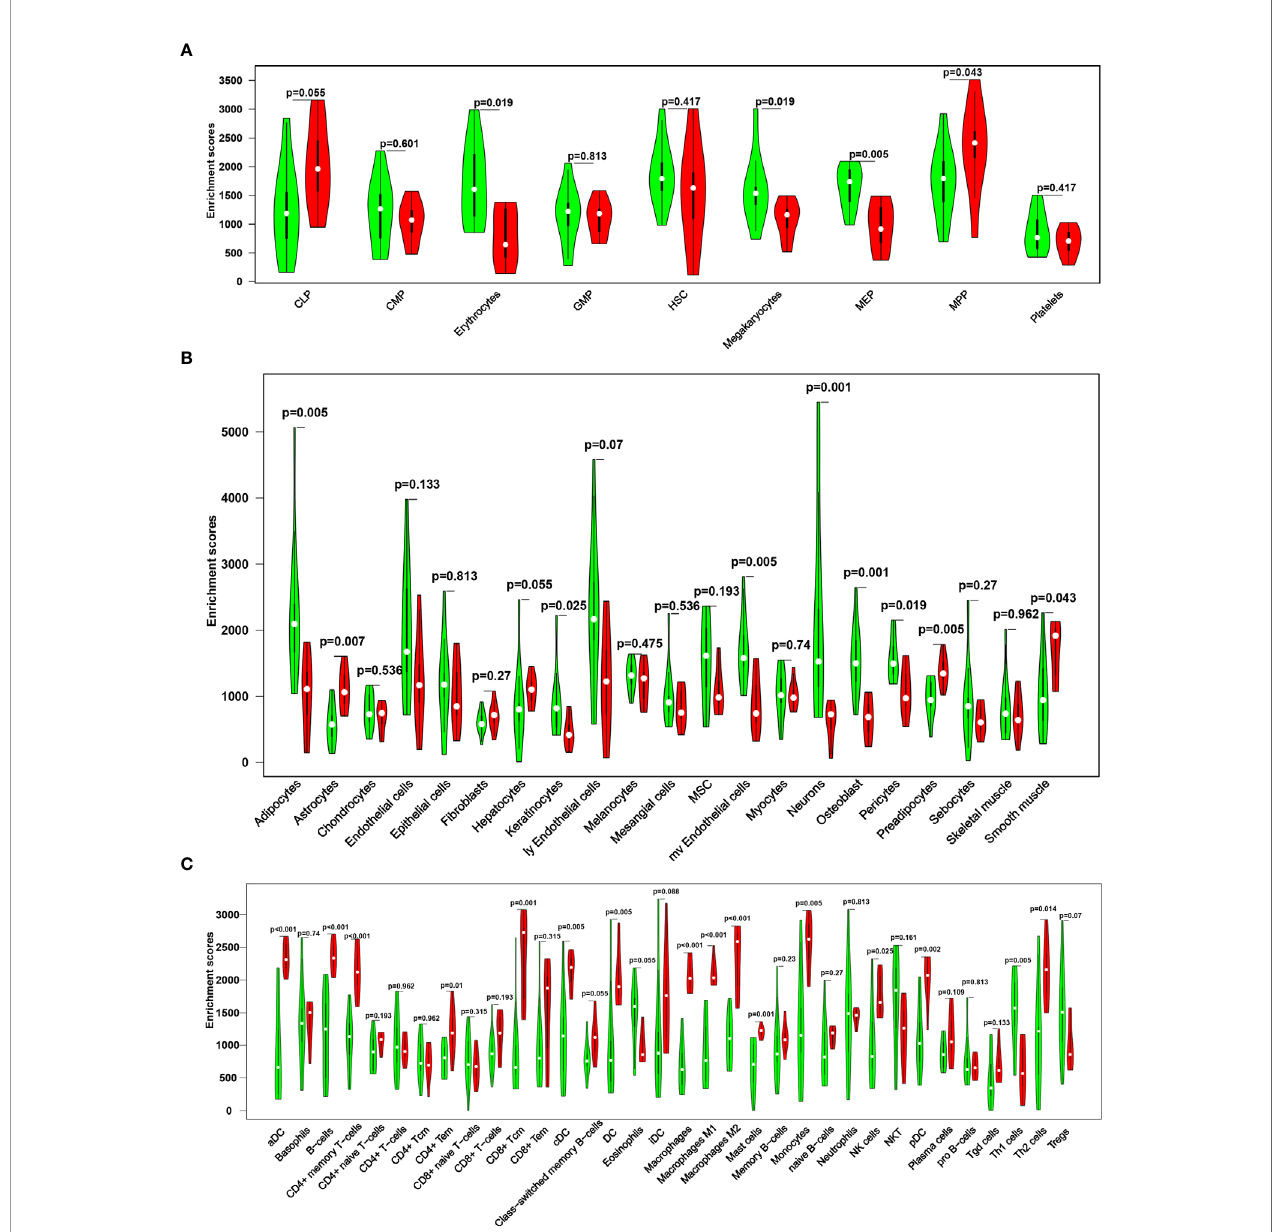
FIGURE 2 | A violin diagram comparing the proportion of hematopoietic stem cells (A) , stroma and epithelial cells (B) , and immune cells (C) in the brain tissues of two groups. Green represents the control group, and red represents the MS group. P < 0.05 was considered statistically signi fi